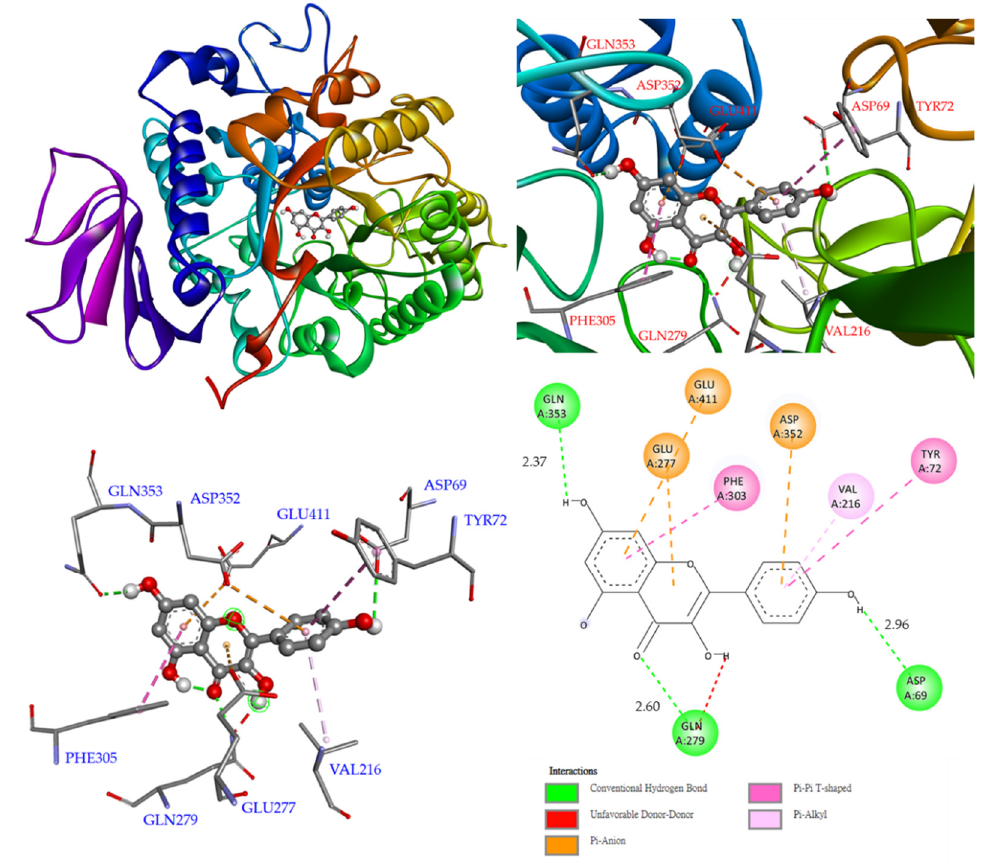
Figure 6. Interactions of kaempferol ( 3 ) with active sites of S. cerevisiae α -glucosidase.